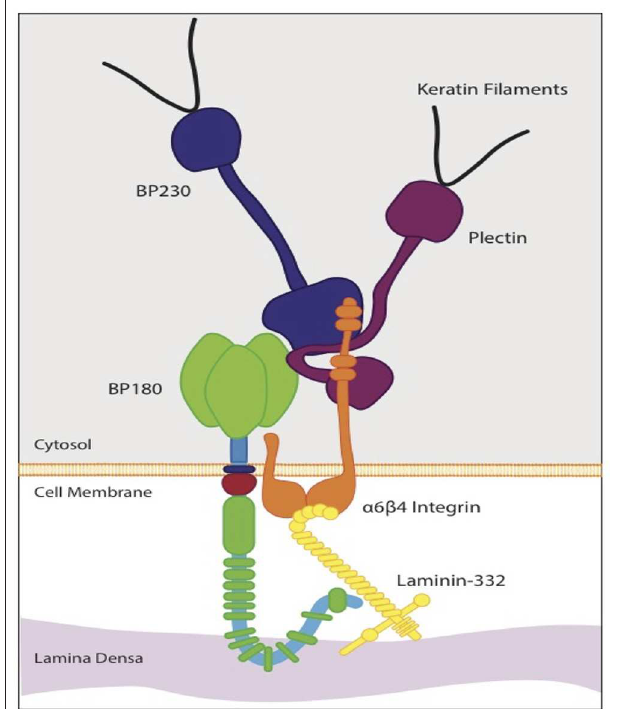
FIGURE 1 | Schematic diagram of the molecular organization of a hemidesmosorne at the dermoepidermal basement membrane. The intracellular plaque is associated with transmembrane adhesion molecules, including integrins and transmembrane type XVII collagen (BP 180). It contains plectin and BP 230 (BPAG1). Type XVII collagen regulates expression and function of laminin- 332. The interaction between laminin-332 and the extracellular portions of a6 β 4 integrin stabilizes hemidesmosomes. This interaction is essential for hemidesmosome formation and epithelial adhesion.